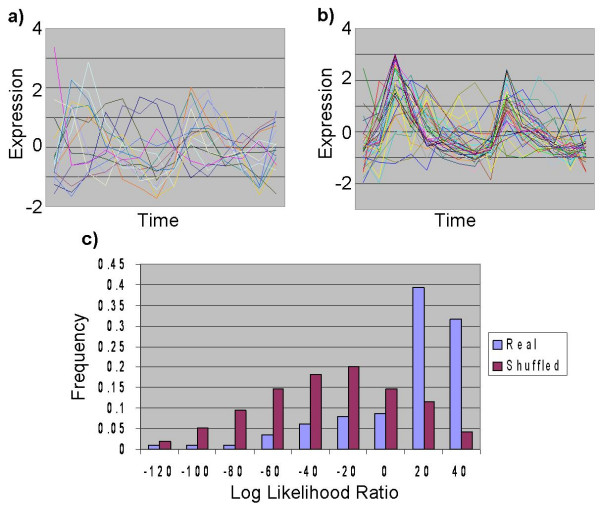
Cell cycle expression profiles for genes with (a) negative log likelihood ratio (better fit to the neutral model) MCB sites and (b) positive log likelihood ratio MCB sites in their promoter. The x-axis represents experimental timepoints through the cell cycle, and the y-axis represents relative gene expression levels (Z-scores). (c) Log likelihood ratios of the true MCB motif (blue) and shuffled MCB motifs (purple).